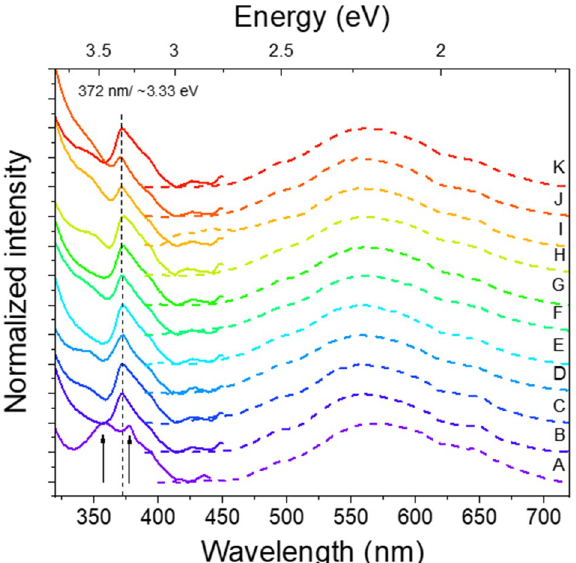
Figure 8. Normalized PL/PLE spectra of the LIG/ZnO composites. The spectra were vertically shifted for clarity. Solid lines: PLE @ 557 nm (peak of the orange band); Dash-dot lines: PL @ 325 nm (Xe